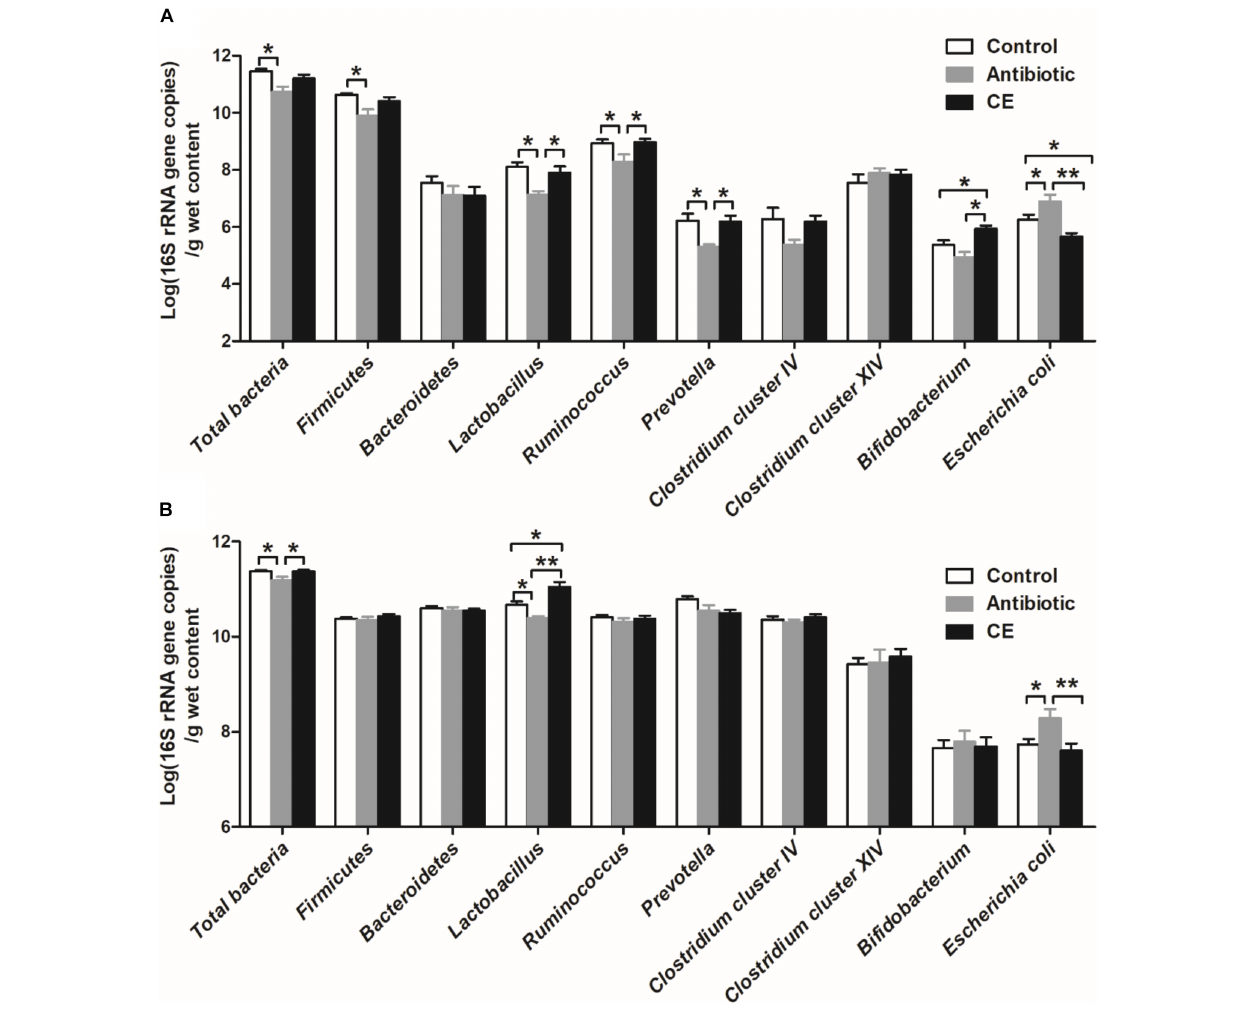
FIGURE 4 | Response of the copy numbers (Log 10 gene copies/g digesta sample) of major bacterial taxonomic groups in the ileal (A) and cecal (B) digesta of Chinese yellow-feathered broilers toward citrus extract treatment. The values are means ± SEM ( n = 6). Asterisks indicate statistical differences between